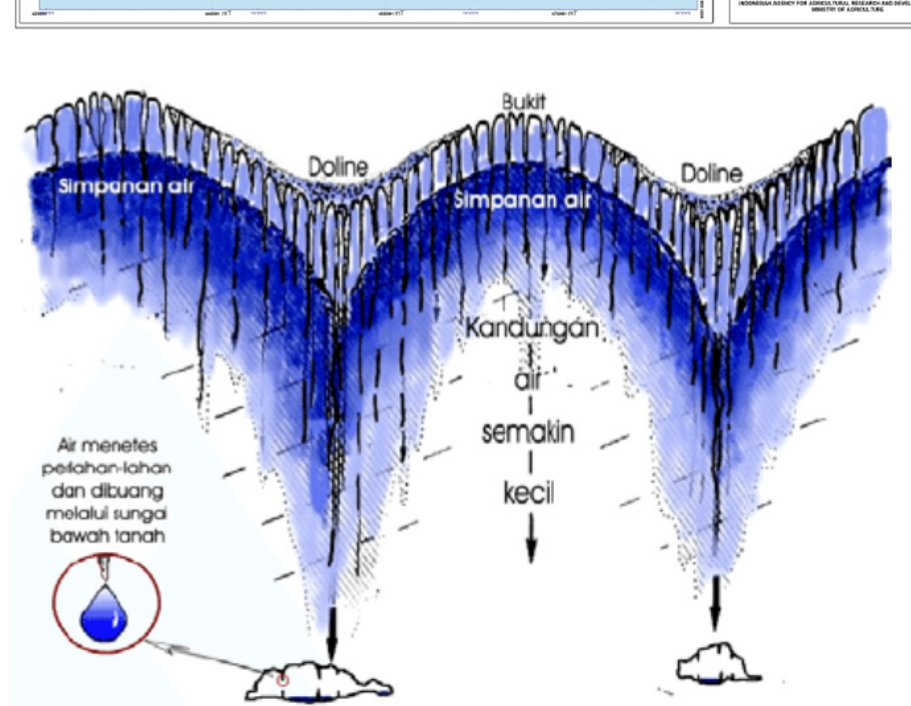
Figure 2. Karst characteristics in Gunungkidul, Yogyakarta, Indonesia. (Data from: Srihartanto and Widodo [22] and Adji, Tjahyo and Haryono, Eko. [23])